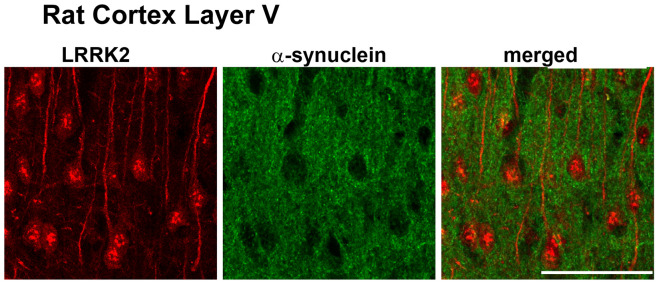
Adapted from West et al. (2014). Leucine-rich repeat kinase 2 (LRRK2) (red) is highly expressed in layer IV/V pyramidal neurons in the mouse motor cortex.